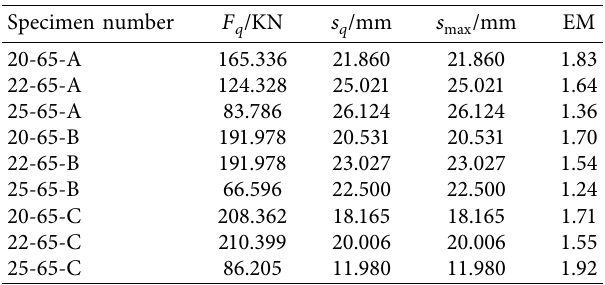
Figure 7: Influence of material properties on specimen performance. (a) 20mm diameter steel bar. (b) 22mm diameter steel bar. (c) 25mm diameter steel bar. Table 4: Specimen yield point data collection